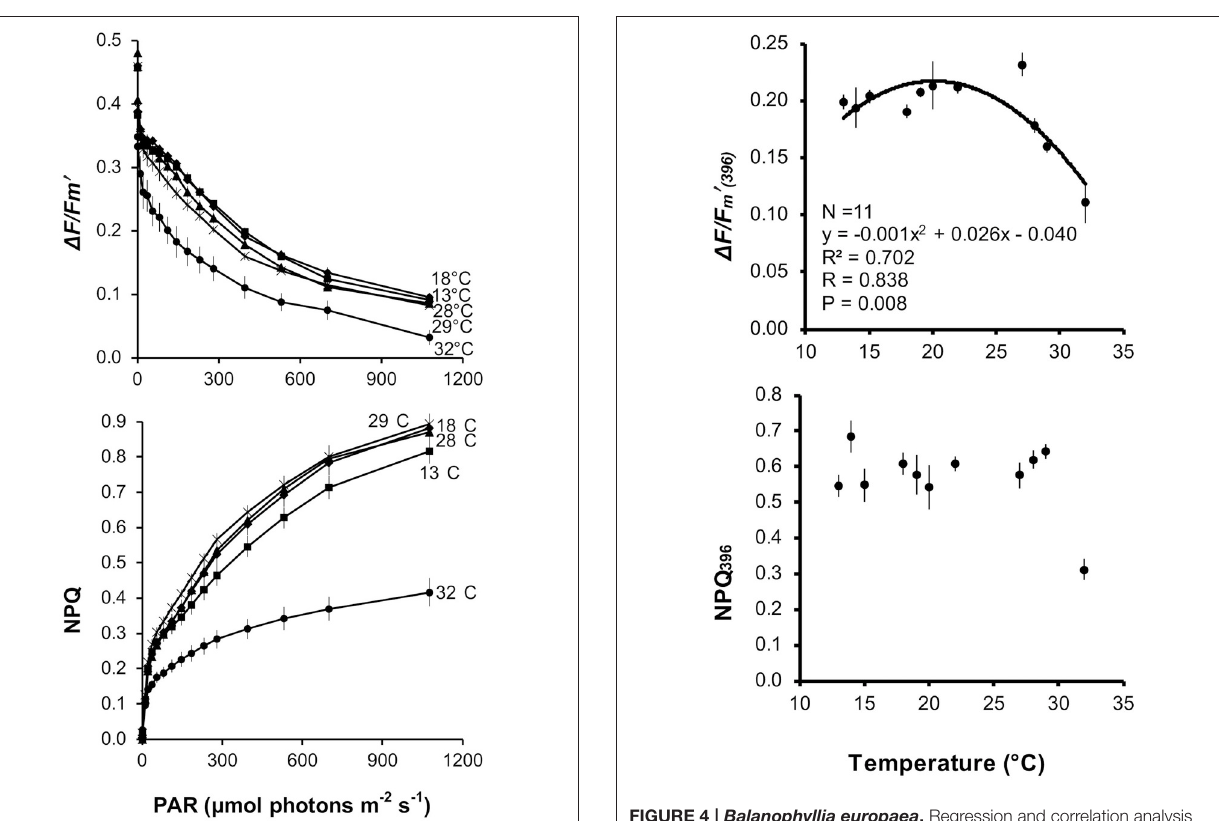
FIGURE 4 | Balanophyllia europaea . Regression and correlation analysis between effective quantum yield at 396 PAR [ 1 F/F m ′ (396) ], non-photochemical quenching at 396 PAR (NPQ 396 ), and temperature using a quadratic function model. Error bars are standard errors. N number of temperature